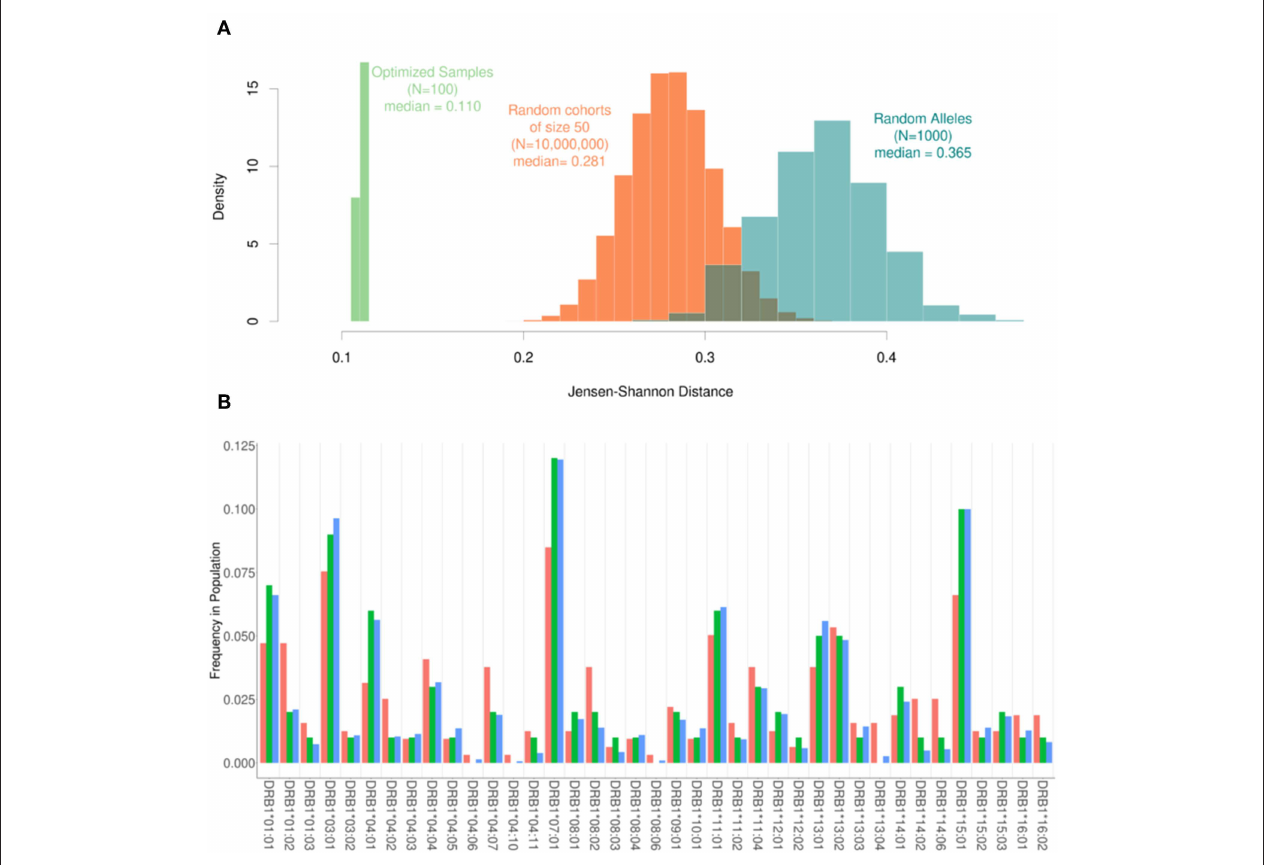
FIGURE 3 | The range of Jensen-Shannon distances. (A) 10,000,000 random samples of 50 subjects were drawn from our pool of donors and their similarity to the background distribution of North Americans was calculated using JSD (Orange) with a median value of 0.281. Additionally, 100 samples were created using our optimization algorithm (Green). These 100 samples all had a sample size of 50 and were run using one substitution per iteration and 10,000 iterations. The scores obtained using the algorithm were roughly 7 standard deviations below the mean of the scores for the random samples with a median score of 0.110. In addition, 1000 sets of completely random alleles were selected (Blue). These random sets, which were meant as a negative control, have a median score of 0.365. (B) The frequency of alleles in the background distribution of alleles in the North American Population (blue) was compared to both the entire set of 159 subjects available (red) and a smaller subset of 50 subjects selected by the algorithm (green). Although the optimized sample is much smaller than the available samples, it is much closer to the desired distribution of